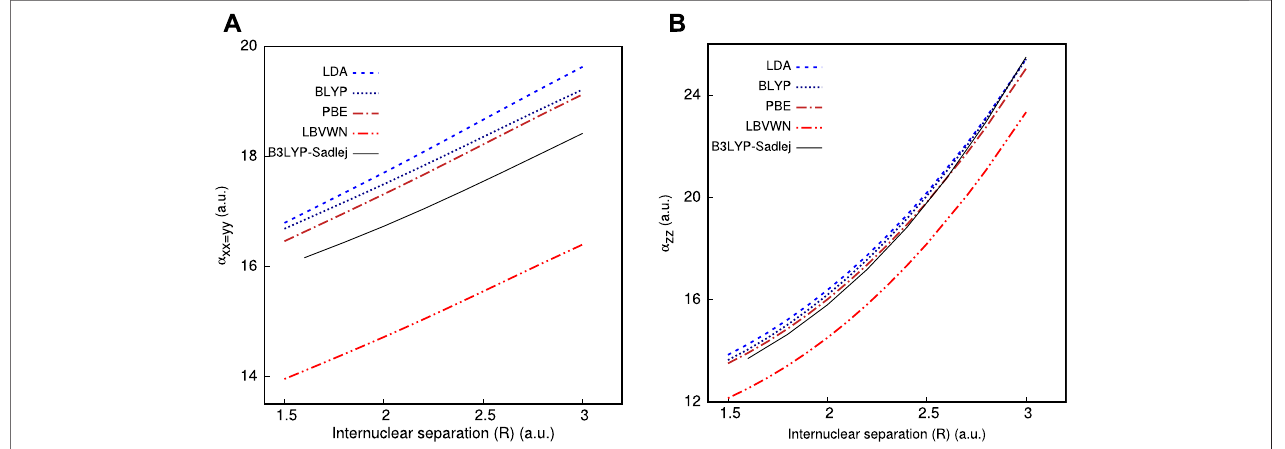
Frontiers in Chemistry |